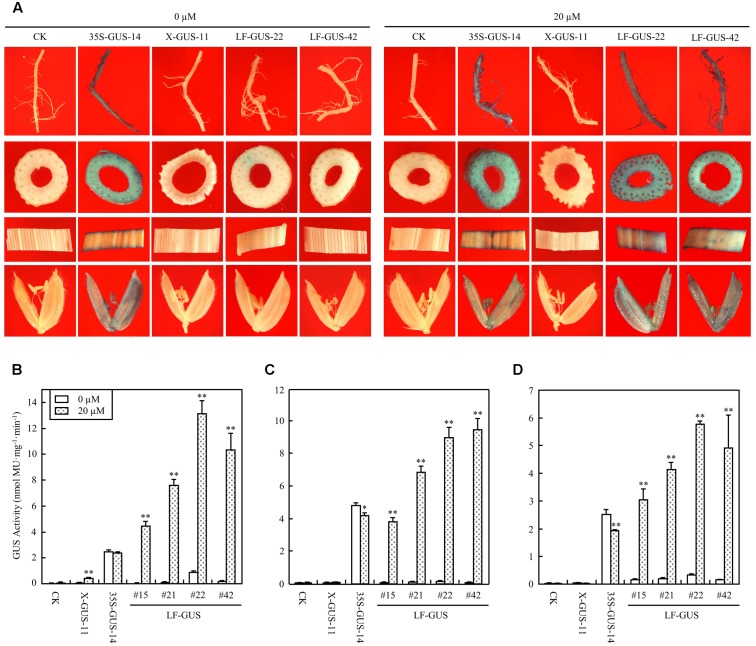
Induced GUS expression in mature LF-GUS transgenic rice plants. (A) GUS staining of the roots, stems, leaves, and florets of mature plants developed from seeds soaked in liquid solution with 0 or 20 μM estradiol. CK, non-transgenic wild type control; 35S-GUS-14, pCAMBIA1305-transformed rice line #14; X-GUS-11, pUX-GUS-transformed rice line #11; LF-GUS-22 and LF-GUS-42, pXCLF-GUS-transformed rice line #22 and #42. (B–D) GUS fluorometric assay of the roots (B), stems (C) and leaves (D) of mature rice plants developed from seeds soaked and germinated in liquid solution with 0 or 20 μM estradiol. CK, non-transgenic wild type control; X-GUS-11, pUX-GUS-transformed rice line #11; 35S-GUS-14, pCAMBIA1305-transformed rice line #14; LF-GUS #15, #21, #22, and #42, pXCLF-GUS-transformed rice line #15, #21, #22, and #42. Statistical significances (∗P < 0.05 or ∗∗P < 0.01) between plants developed from seeds soaked in 0 or 20 μM estradiol were analyzed by Student’s t-test.